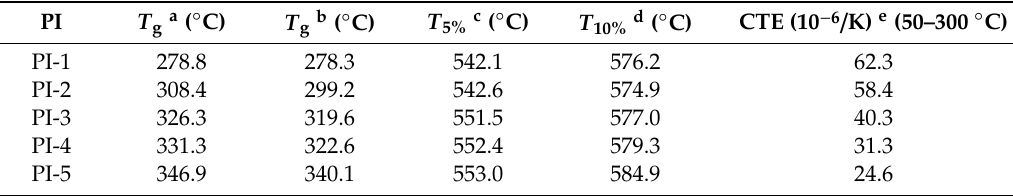
Table 2. Thermal properties of PI coatings.